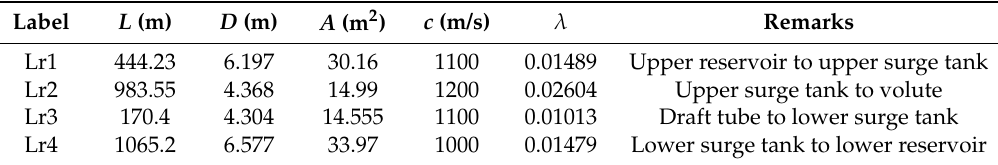
Table A4. Actual physical parameters of pipeline